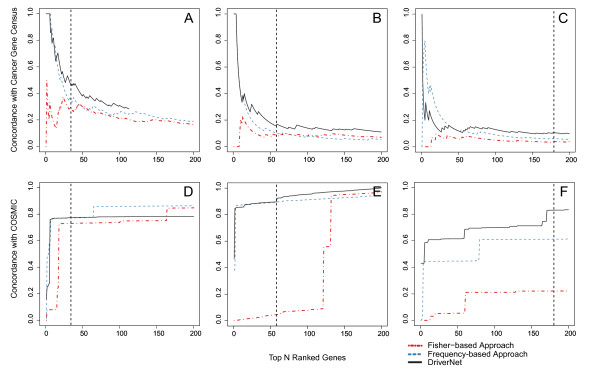
DriverNet performance benchmarking with the GBM2, HGS2, and HGS2 datasets. (A-C) Concordance with Cancer Gene Census for DriverNet, Frequency-based, and Fisher-based approaches as a function of the top N ranked genes (out of 200) for the GBM2, TN2, and HGS2 datasets, respectively. (D-F) Concordance with the COSMIC database (cumulative distribution of mutation prevalence in the COSMIC database) for DriverNet, Frequency-based, and Fisher-based approaches as a function of the top N ranked genes (out of 200) for the GBM2, TN2, and HGS2 datasets, respectively. Note that for the GBM2 dataset, DriverNet nominates 113 genes as candidate drivers, therefore, the concordance of DriverNet genes with the Cancer Gene Census is plotted for the 113 candidates.